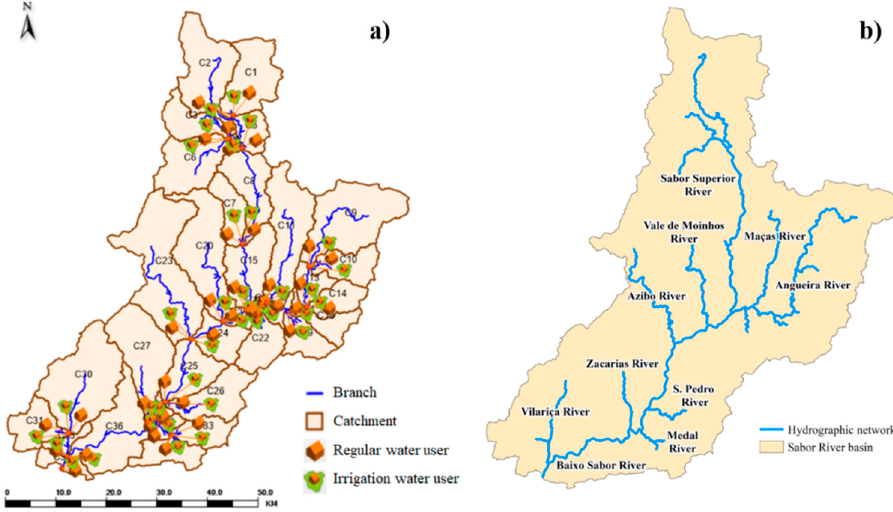
Figure 3. ( a ) The drainage networks, regular water users, and irrigation users at sub-basin scale in MIKE HYDRO Basin and ( b ) all tributaries of the Sabor River